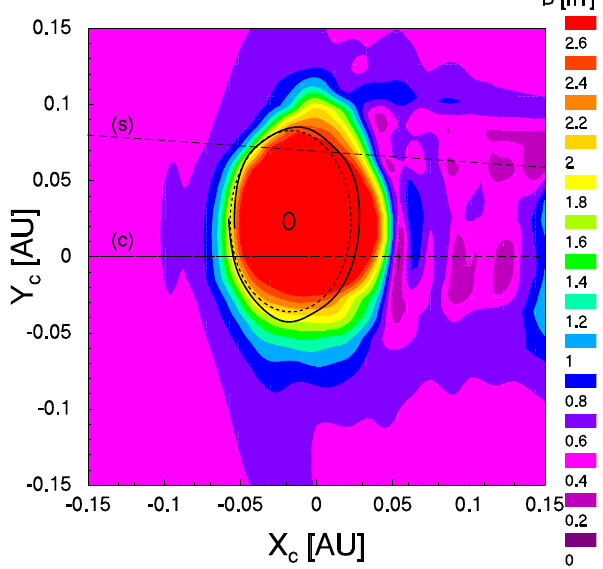
Fig. 3. Cross section through the flux rope around the point A for the event I. Contours show the distribution of the magnetic field magnitude. Thick ovals are projected parts of magnetic field lines. Dashed straight lines are projected trajectories of hypothetic space- craft. X c and Y c are axes of a local Cartesian coordinate system with the Z c axis along the estimated flux rope axis (the red arrow from Fig. 1). So the X c and Y c axes lie in the plane perpendicular to the flux rope axis, but their orientation in this plane is selected